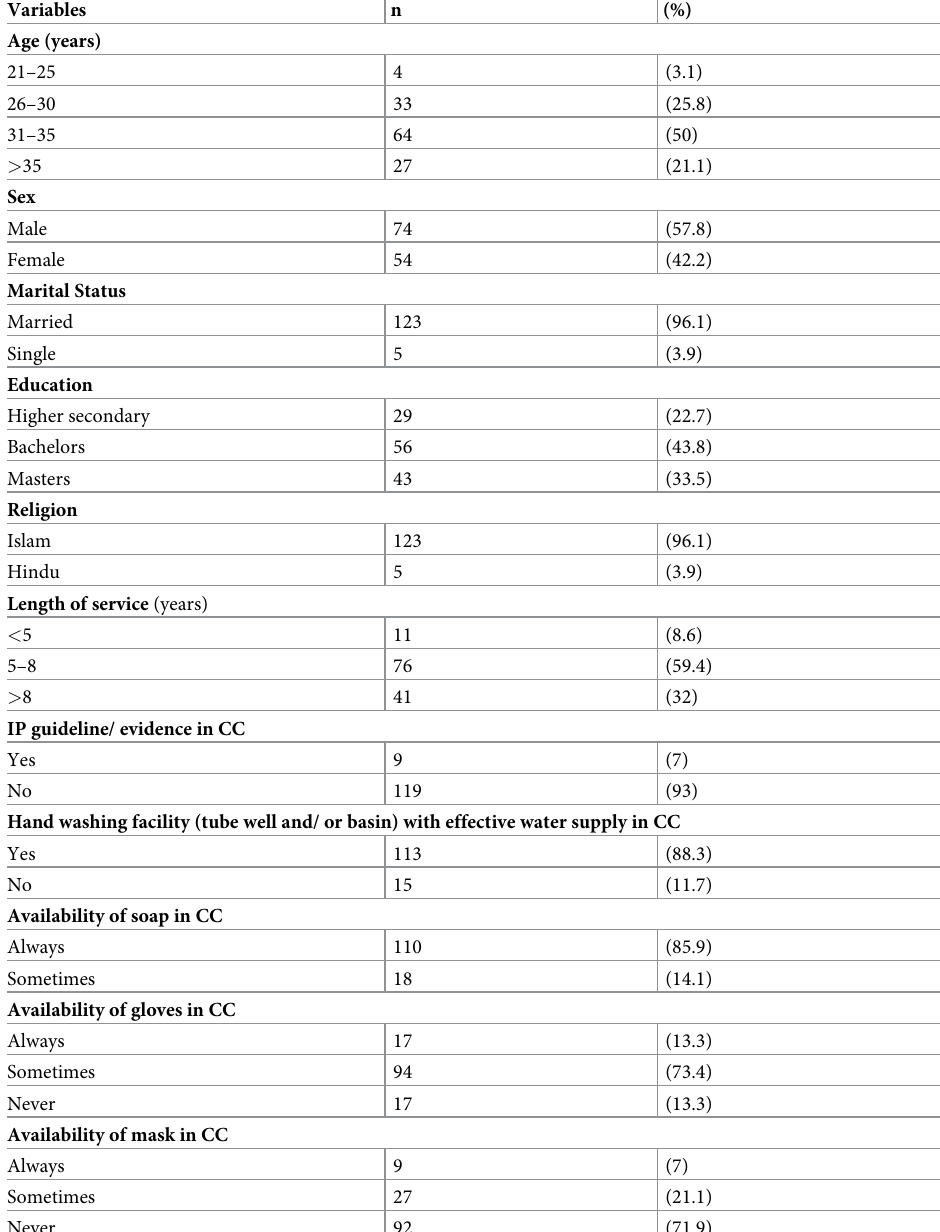
Table 1. General characteristics of the sample (n =